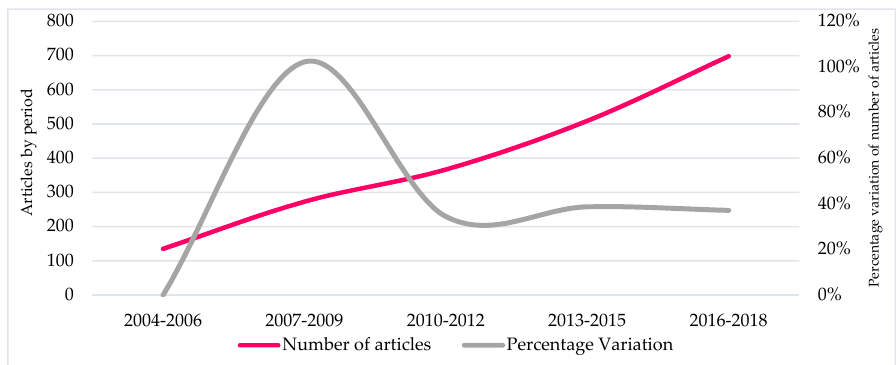
Figure 3. Progression of the number of articles and percentages of variation between triennials.